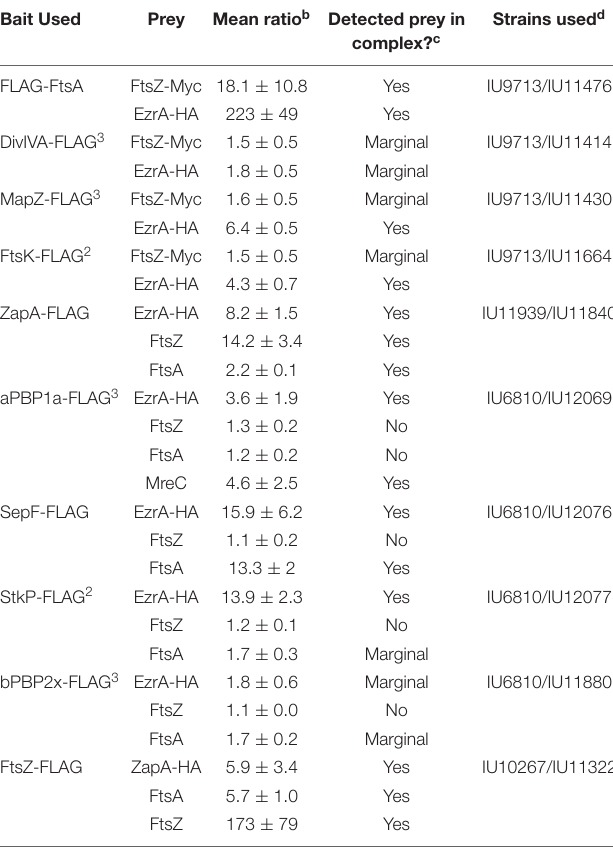
TABLE 3 | Co-immunoprecipitation of FLAG-tagged divisome proteins from cross-linked Spn cells a . Bait Used Prey